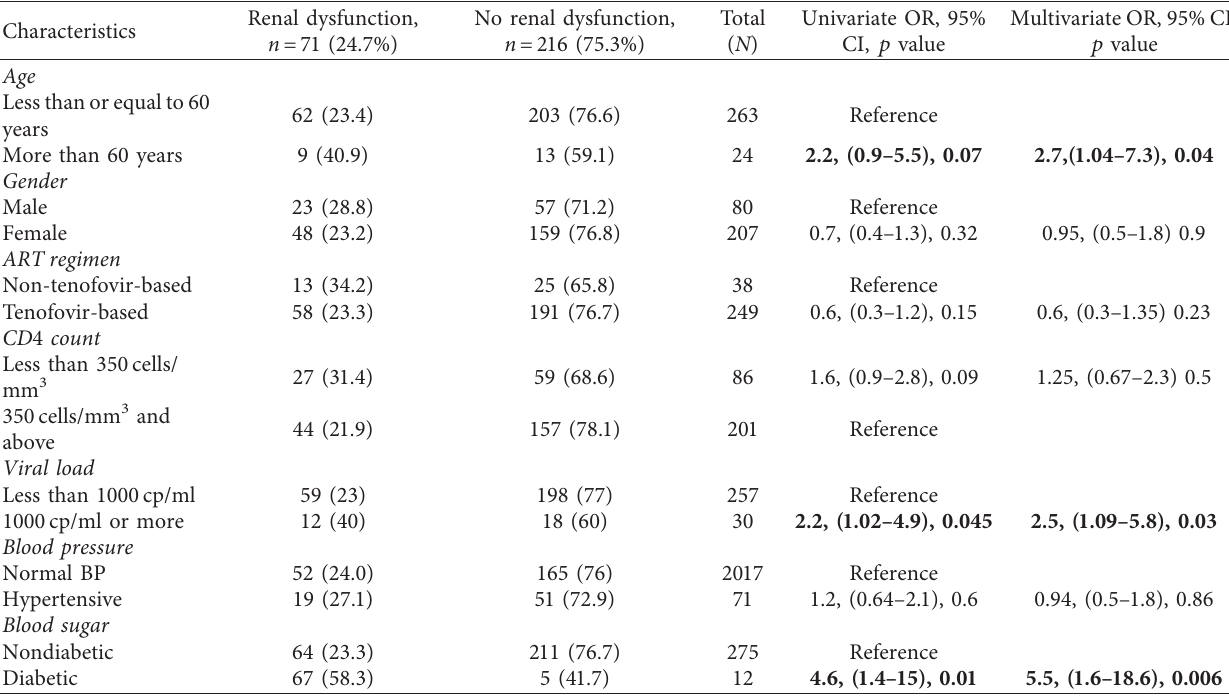
Table 2: Factors predictive of renal dysfunction among HIV patients on antiretroviral therapy at Muhimbili National Hospital ( N � 287). Renal Characteristics